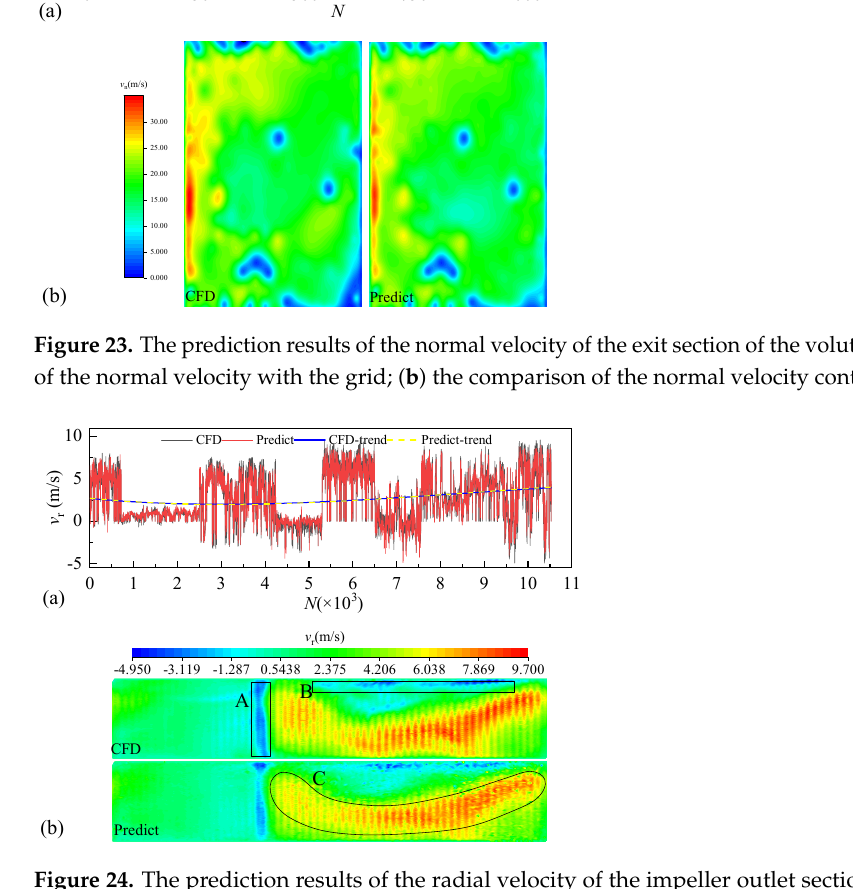
Figure 24. The prediction results of the radial velocity of the impeller outlet section: ( a ) the radial velocity changes with the grid; ( b ) the comparison of the radial velocity contour.